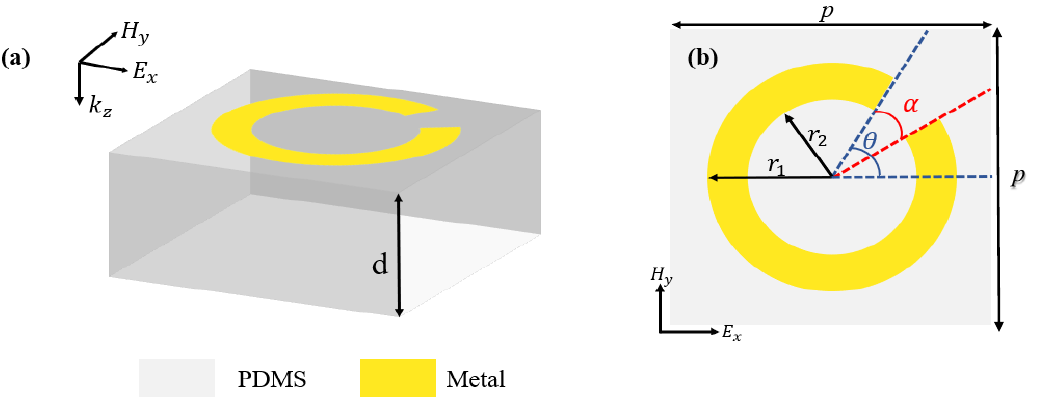
Figure 1. Unit cell structure of the C-shaped metal SRR. ( a ) Three-dimensional illustration of the unit cell structure; ( b ) top view of the unit cell structure.